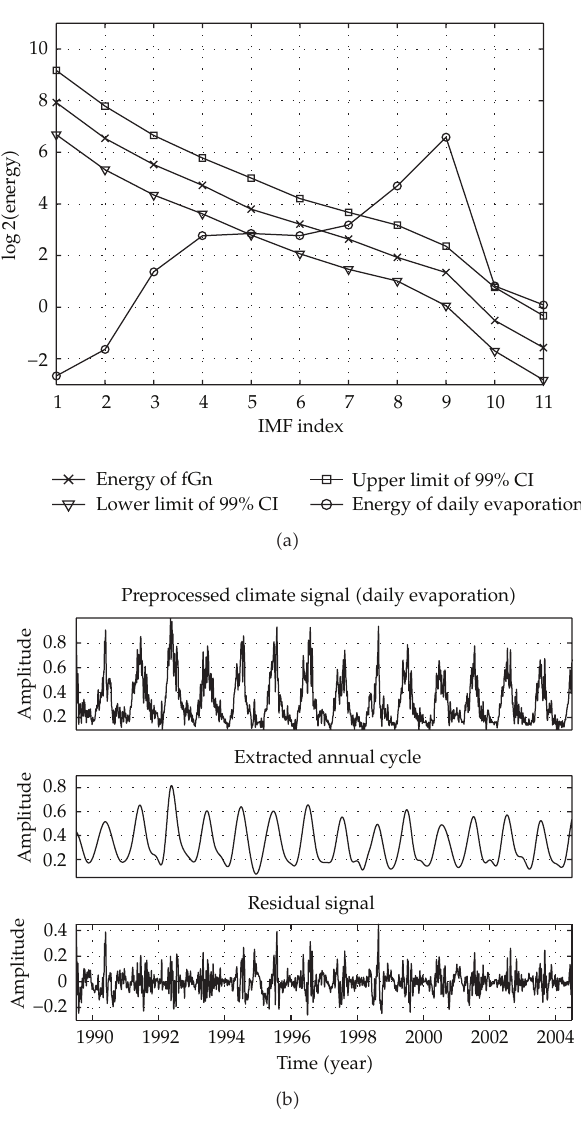
Figure 8: (cid:2) a (cid:3) The energy distribution of fGn over the IMFs, its upper and lower bounds with 99% confidence interval. The energies of individual IMF of daily evaporation signal indicate that the 8th one is the starting IMF to represent the annual cycle. (cid:2) b (cid:3) The separation of annual cycle of daily evaporation. The preprocessed climate signal (cid:2) top (cid:3) , extracted annual cycle (cid:2) middle (cid:3) , and the residual signal (cid:2) bottom (cid:3)